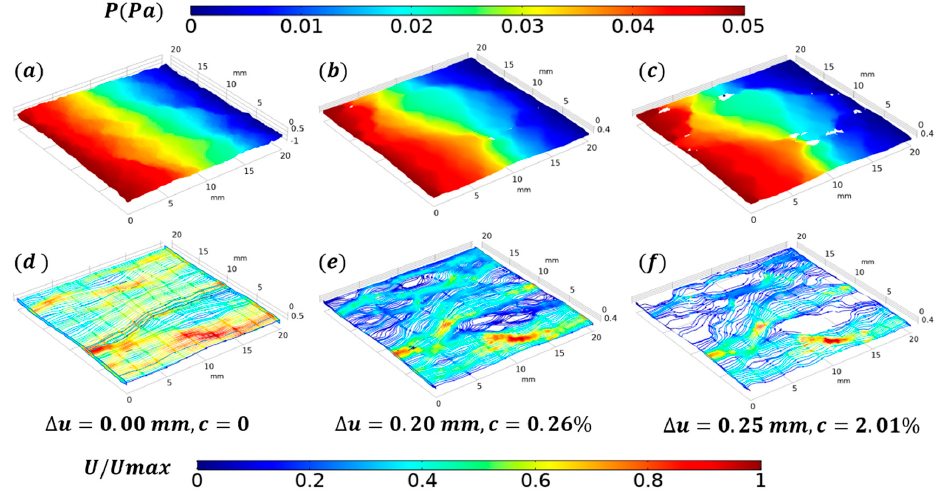
Figure 6. Variations of pressure fields and flow streamlines for fractures of different Δ u with H = 0.65: ( a – c ) are pressure fields (unit: Pa); and ( d – f ) are flow streamlines.